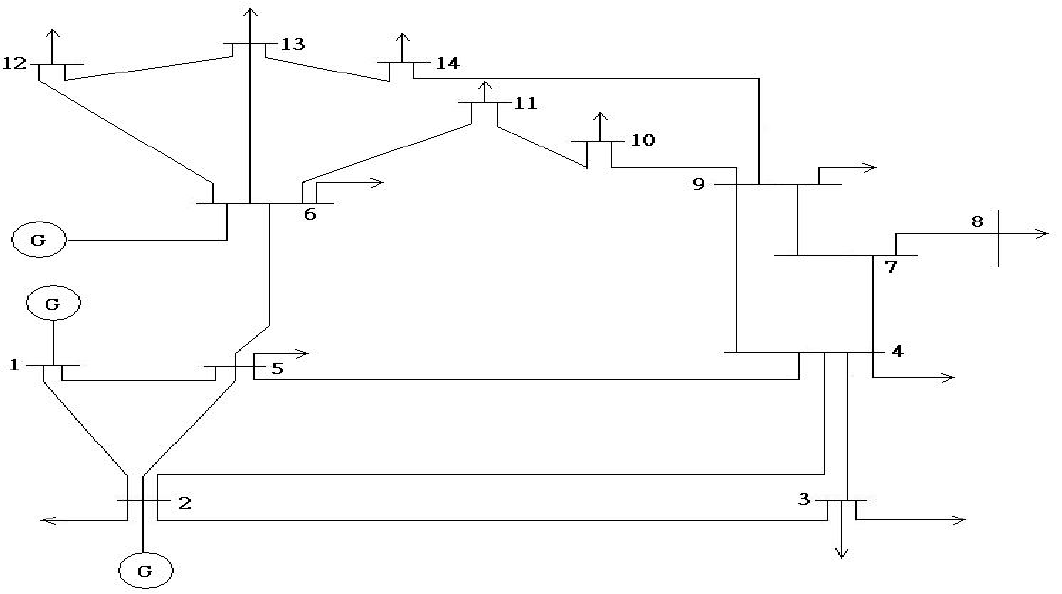
Figure 4. IEEE 14-bus test system.